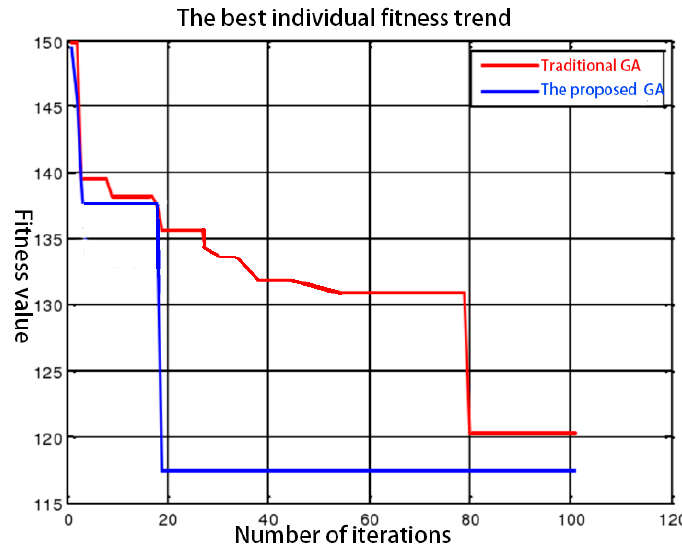
Figure 14. Two algorithms for fitness.